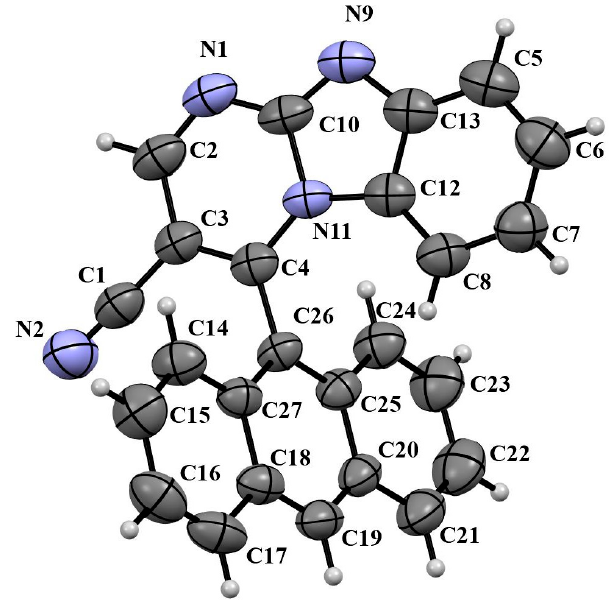
Figure 10. The compound 6c in the thermal ellipsoid at the 50% probability level.